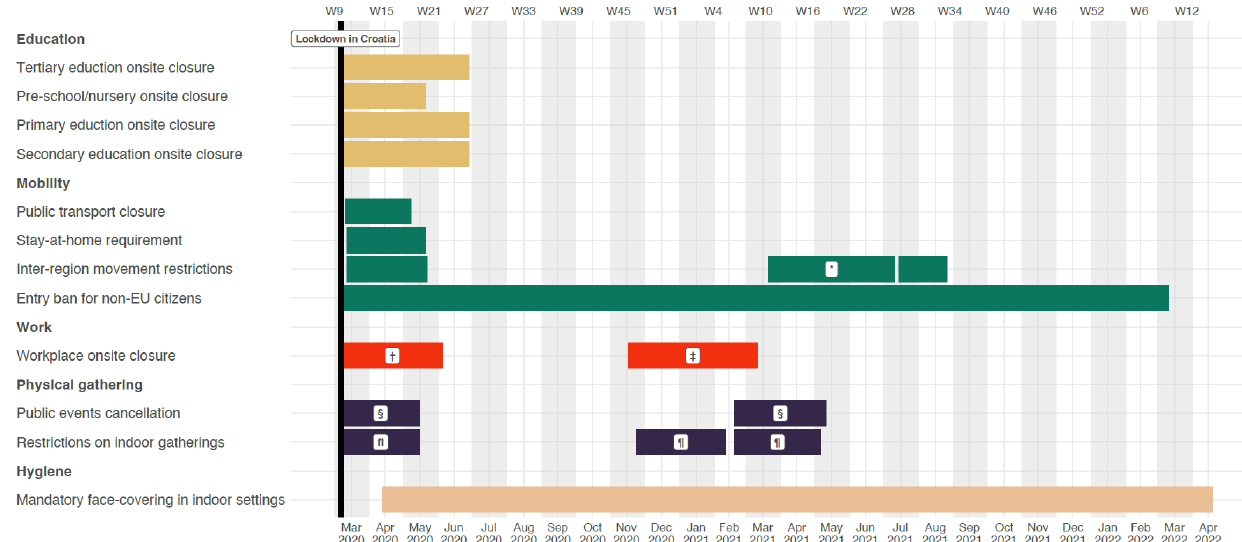
Figure 1. Timeline of implementation and relaxation of non-pharmaceutical interventions in response to the COVID-19 pandemic in Croatia. Five categories of non-pharmaceutical interventions were summarized: education, mobility, work, physical gathering, and hygiene from 16 Mar 2020 to 4 April 2022. Black vertical line indicates when lockdown was in Croatia on 16 March 2020. * Total border closure. † Closure of public spaces. ‡ Restaurants and cultural institutions closure. § Ban on holding all public events. fI Ban on gathering >5 persons in one place. ¶ Ban on gathering >10 per- sons in one place.